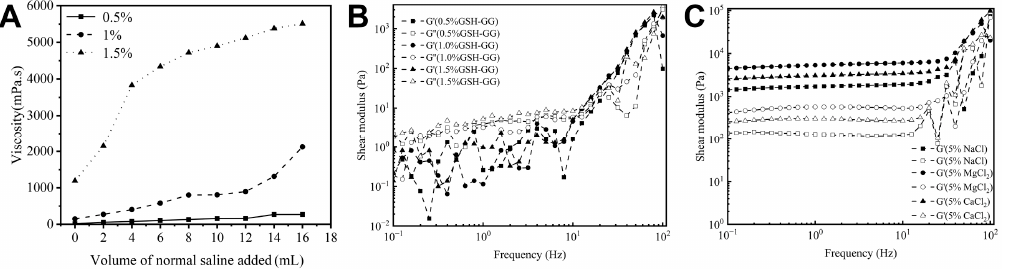
Figure 1. ( A ) Viscosity changes in DOX-containing GSH-GG with different concentrations after adding normal saline. ( B ) Rheological curves of the GSH-GG hydrogels prepared at different concentrations. ( C ) Rheological curves of the GSH-GG hydrogels with the concentration of 1.5% ( w / v ) after adding liquid of different ionic strength.